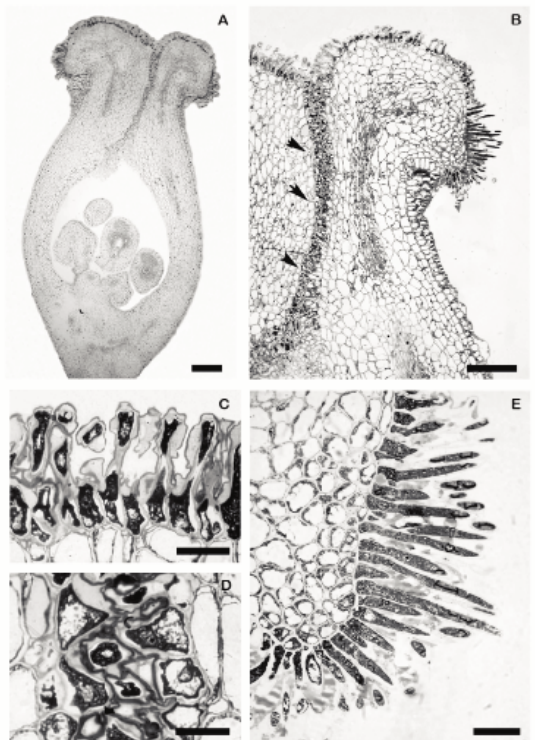
Fig. 4 -Light micrograph of the pistil of B. microphylla G. Forst. A, longitudinal section of a flower on stage 59.B, view of stig- ma and the upper end of the ovary; C, glandular cells of the flat part of stigma; D, detail of glandular cells of fusion area of the carpel; E, detail of hairs surrounding the stig- ma. Bars: A= 100 µm; B= 200 µm; C-E= 50